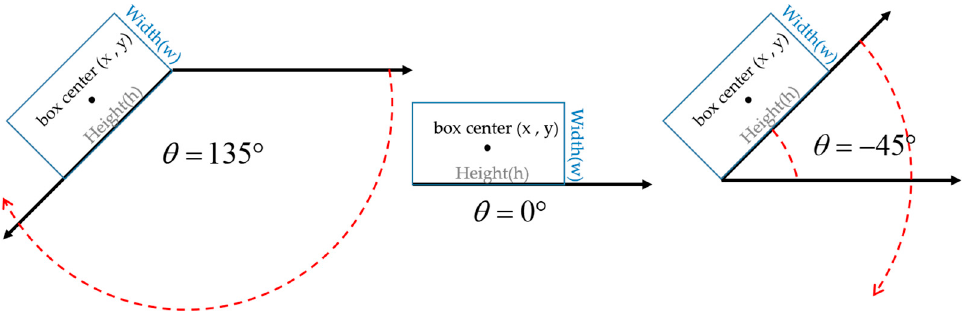
Figure 7. Geometric representation of rotated bounding boxes.